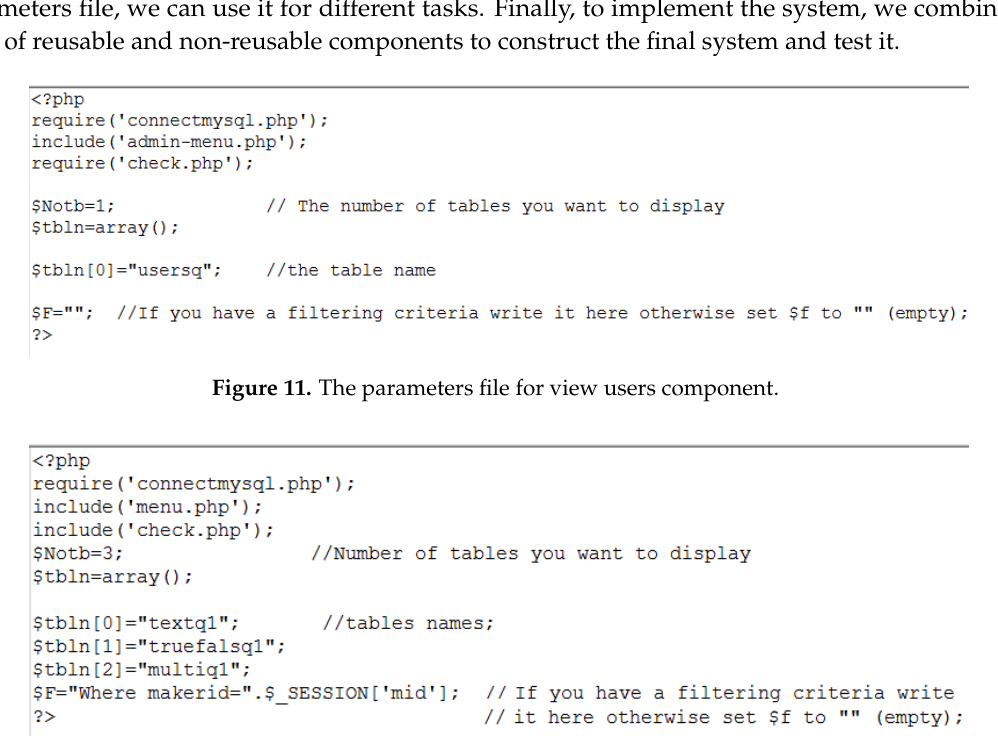
Figure 12. The parameters file for view questions